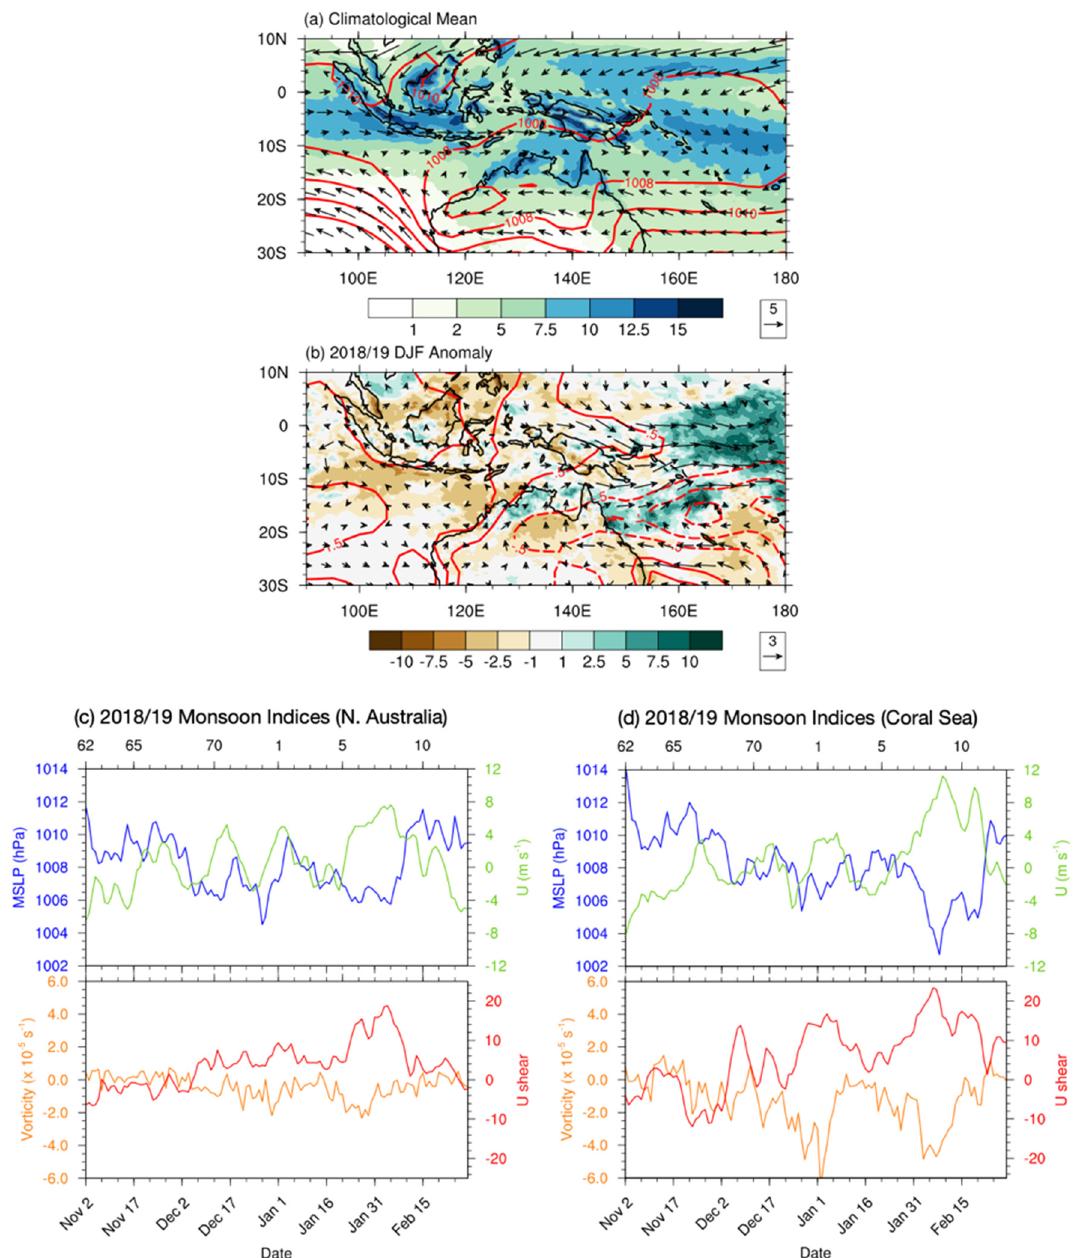
Figure 2. ( a ) Climatological seasonal mean precipitation (shaded, unit: mm day − 1 ), sea level pressure (SLP, contours, level by 2 hPa), and 850-hPa wind (vectors, unit: m s − 1 ), and ( b ) their anomaly fields (SLP contours level by 0.5 hPa) during austral summer (December to February). ( c ) The time series of monsoon indices during austral summer 2018/19 over the Australian summer monsoon region (115°~145° E, 5°~20° S), where the blue, green, orange, and red curves indicate the area-mean SLP, 850-hPa zonal wind, 850-hPa relative vorticity over the monsoon region, and zonal wind shear ( U 850 [5 ° – 15 ° S, 115 ° –145 ° E] − U 850 [20 ° –30 ° S, 115 ° –145 ° E]), respectively. ( d ) is the same as ( c ), but for the Coral Sea (145°~165° E, 5°~20° S) and the wind shear is obtained by ( U 850 [5 ° –15 ° S, 145 ° – 165 ° E] − U 850 [20 ° –30 ° S, 145 ° – 165 ° E]).